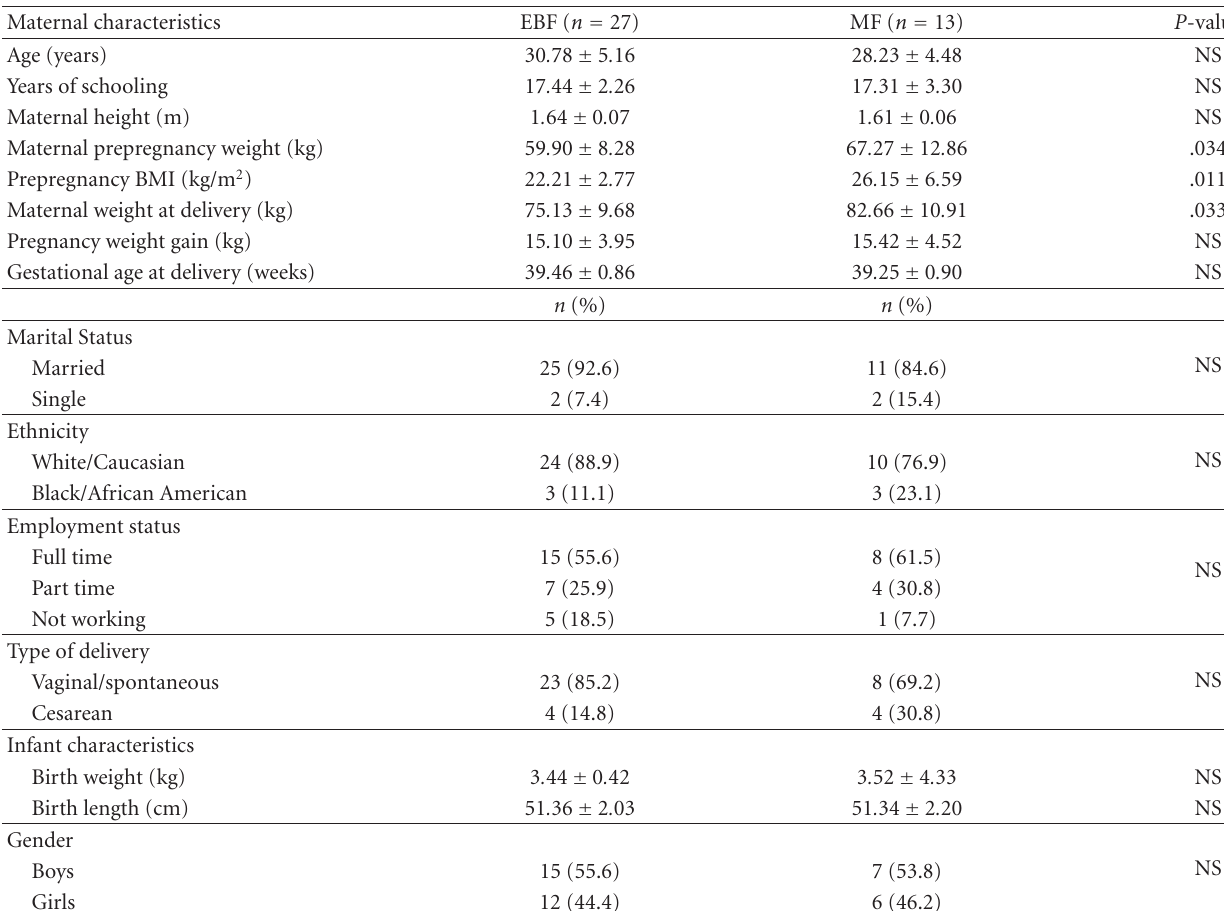
Table 1: Characteristics of mothers and infants according to type of